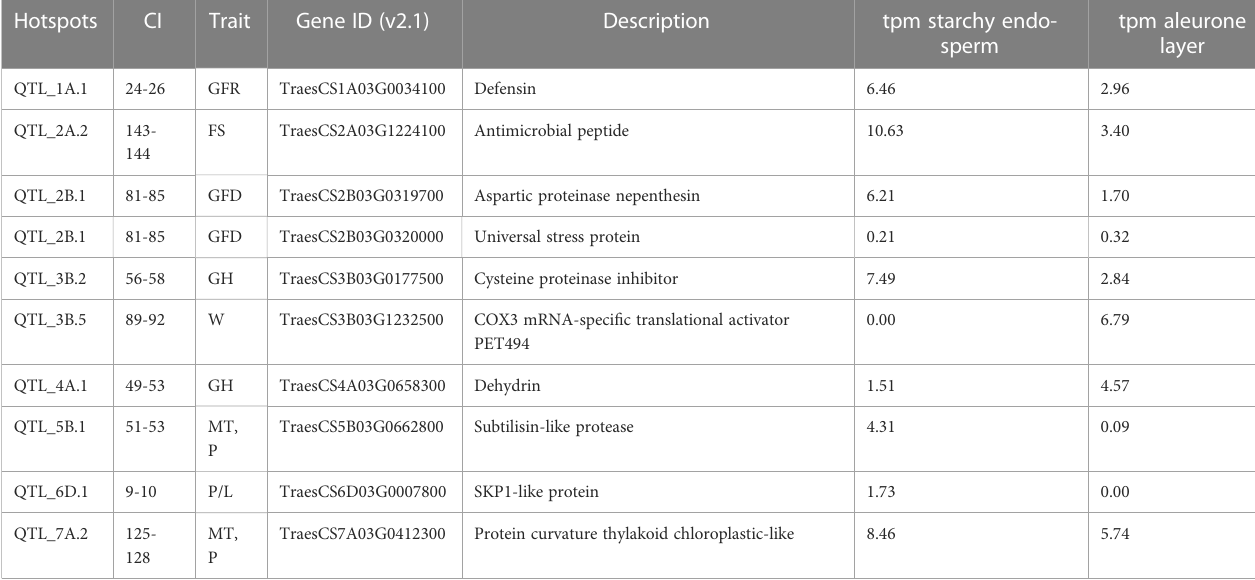
TABLE 4 List of genes differentially expressed in the grain. Hotspots CI Trait Gene ID (v2.1)